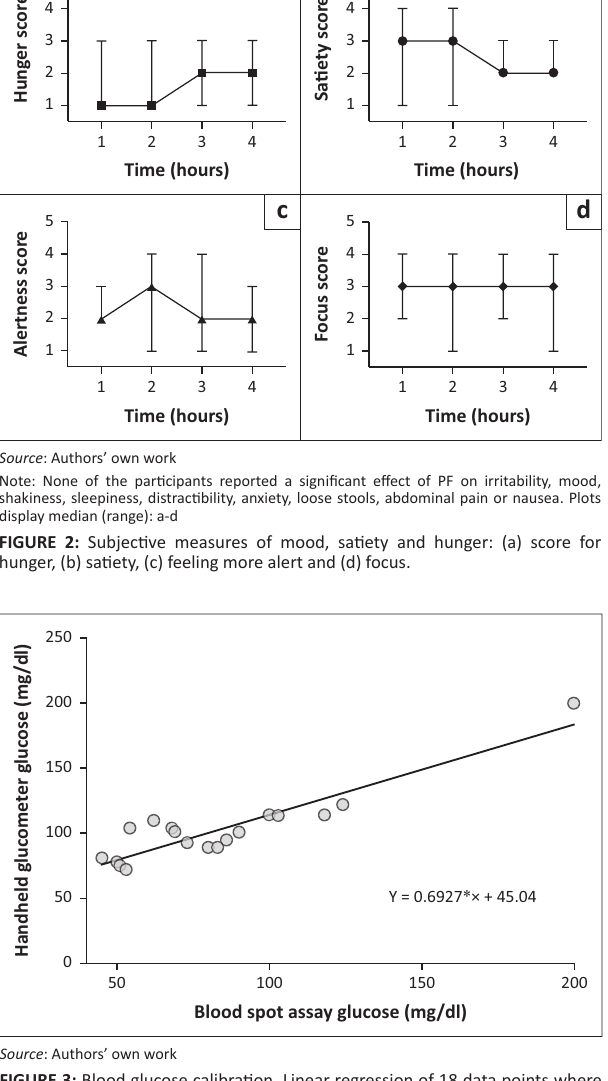
FIGURE 3: Blood glucose calibration. Linear regression of 18 data points where data were available for both the blood spot enzymatic assay and a handheld glucometer. The single point at 200 mg/dl is from one participant (#4) who had data using the same assay after a 100 g glucose load. A significant correlation between the two ( R 2 = 0.83, p < 0.0001) was seen, and the resulting equation (Y = 0.6927 * X + 45.04) was used to adjust glucose measurements for all participants in the analysis.